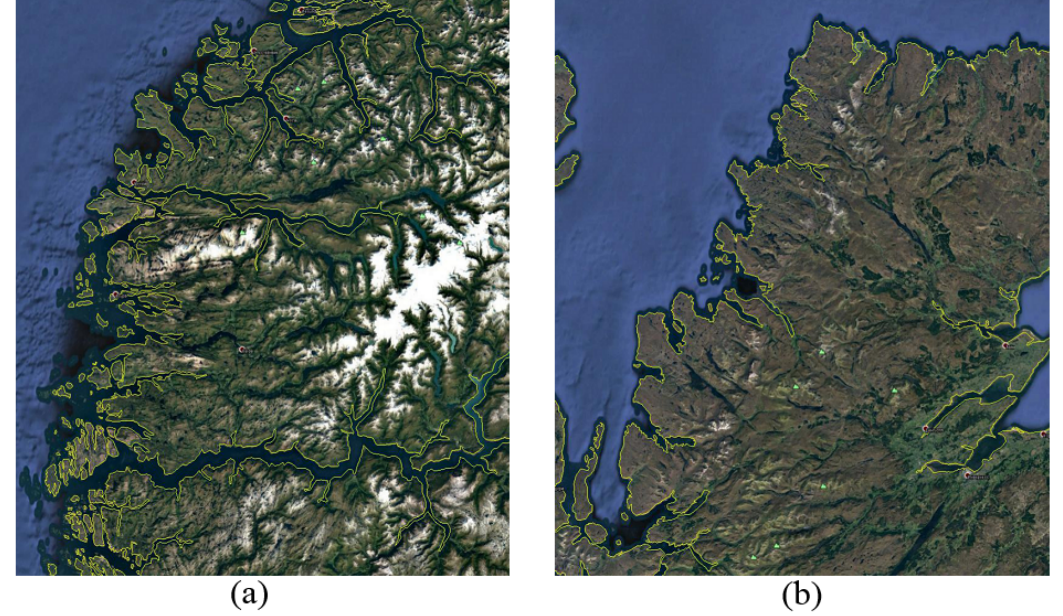
Figure 2. Fragments of the coastline of Norway ( a ) and Great Britain ( b